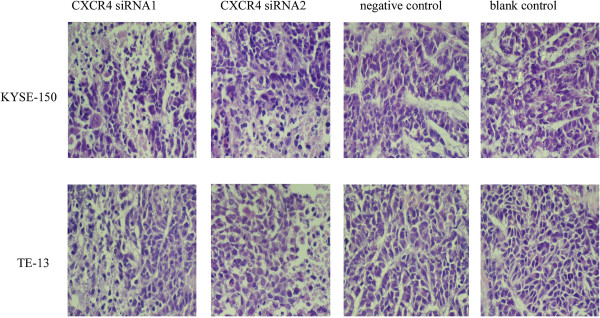
The histopathologic changes of nude mice tumor tissues. The histopathologic changes of tumor tissues from two nude mice models bearing esophageal carcinoma were observed using HE stains. The tumor cells in group CXCR4 siRNA1 and CXCR4 siRNA2 had apoptosis and necrosis, morphology was different from each other, nuclei showed pathological division and the giant tumor cells were rare (400 x).